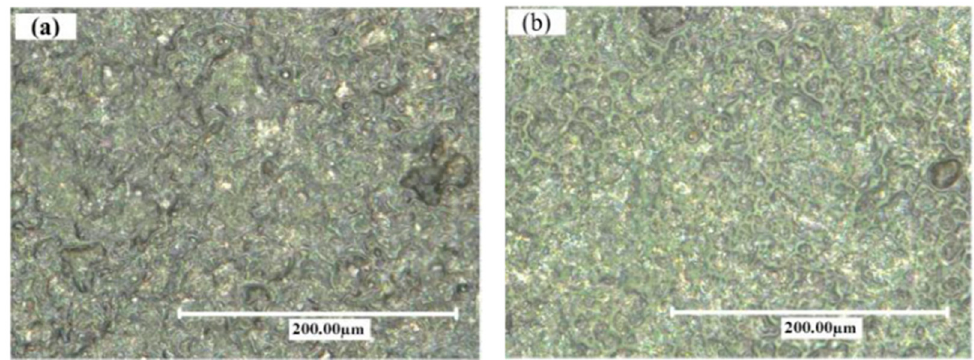
Figure 8. Surfaces of machined SiCp/Al composite obtained by ( a ) conventional EDM and ( b ) powder-mixed EDM [53]. (With kind permission from Elsevier).